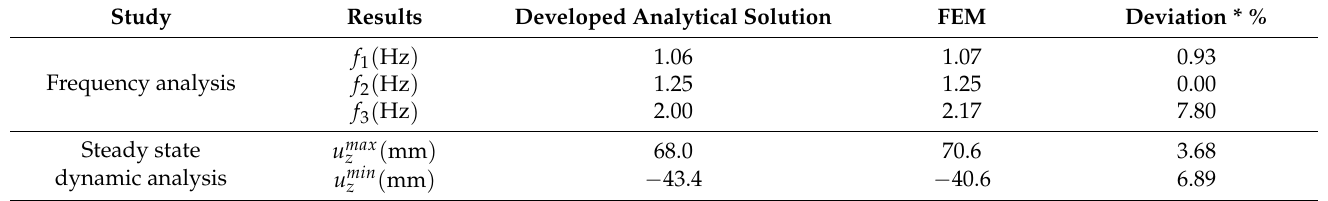
Table 10. Comparison amongst the results obtained from FEM and developed analytical ap- proaches.